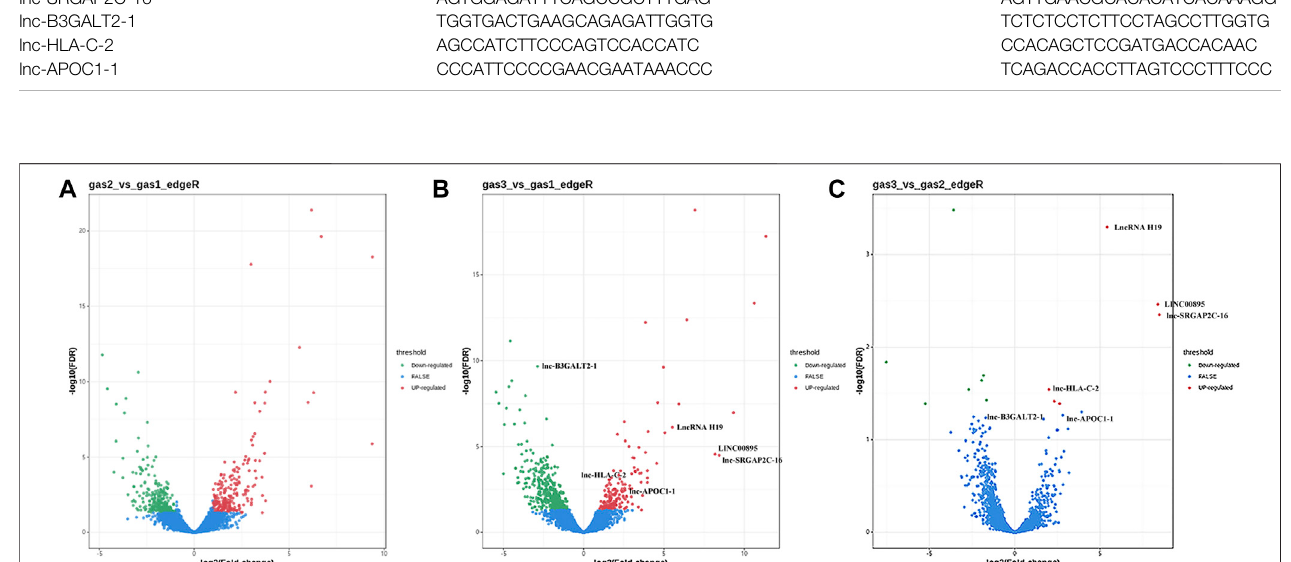
FIGURE1| Thevolcano fi guresofupregulatedanddownregulatedlncRNAs. (A) ThedifferentiallncRNAsbetweengastritisgroup(gas1)andgastricprecancerous lesion group (gas2). (B) The differential lncRNAs between gastritis group (gas1) and gastric cancer group (gas3). (C) The differential lncRNAs between gastric precancerous lesion group (gas2) and gastric cancer group